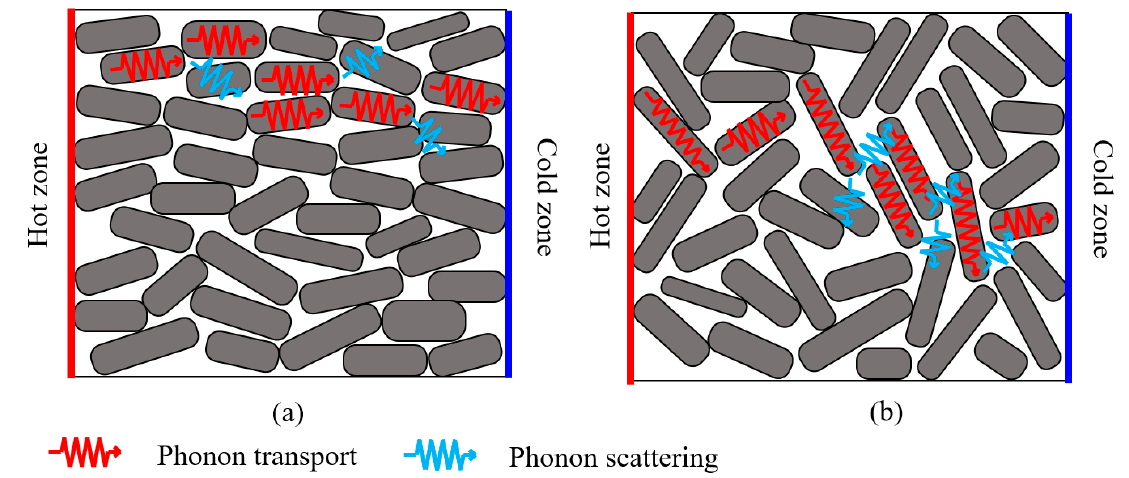
Figure 6. Schematic diagram of phonon transport according to particle orientation: ( a ) high orientation; ( b ) low orientation.